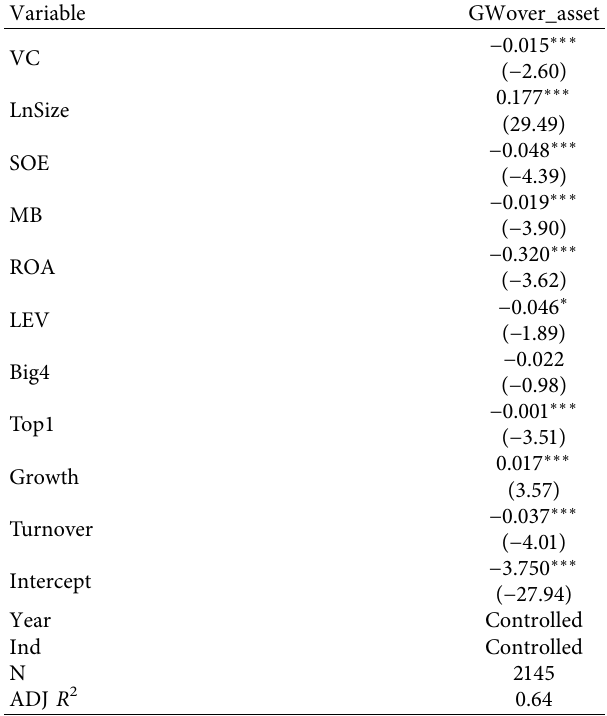
Table 7: PSM regression